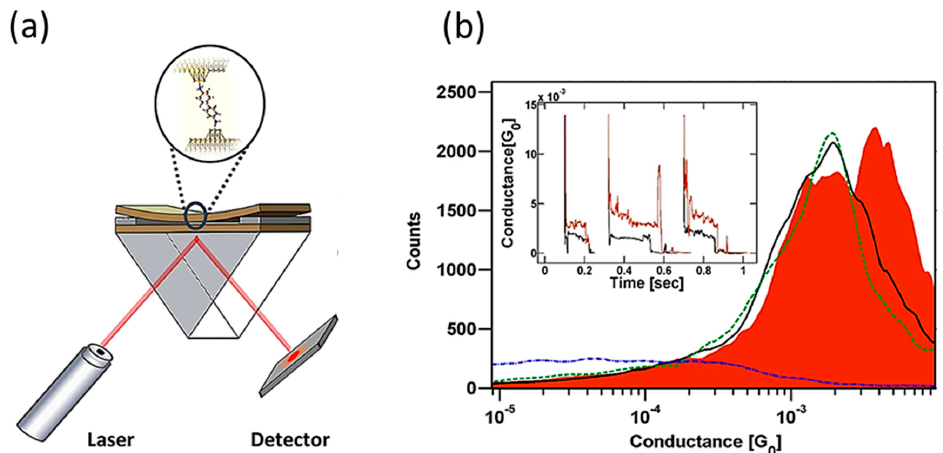
Figure 10. ( a ) Schematic view of squeezable break junction setup for conductance measurement of the molecular junction; ( b ) Conductance histograms of the 2,7-diaminofluorene molecular junction measured without (black curve) and with (red colored area) continuous wave illumination (wavelength: 781 nm, power: 10 mW). Inset: Examples of the conductance traces of the 2,7-diaminofluorene molecular junctions without (black) and with (red) laser illumination [47].